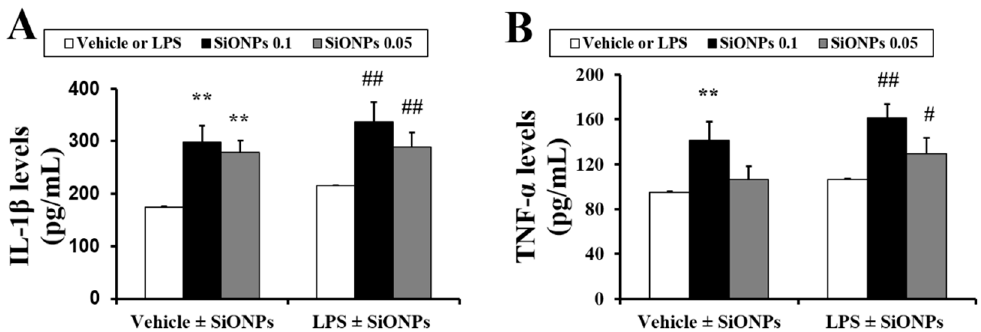
Figure 3. Effect of SiONPs exposure on proinflammatory cytokines in BALF. Levels of ( A ) IL-1 β and ( B ) TNF- α . Data represent the means ± SD ( n = 5 per group). ** p < 0.01 vs. vehicle control. # p < 0.01 and ## p < 0.05 vs. LPS.